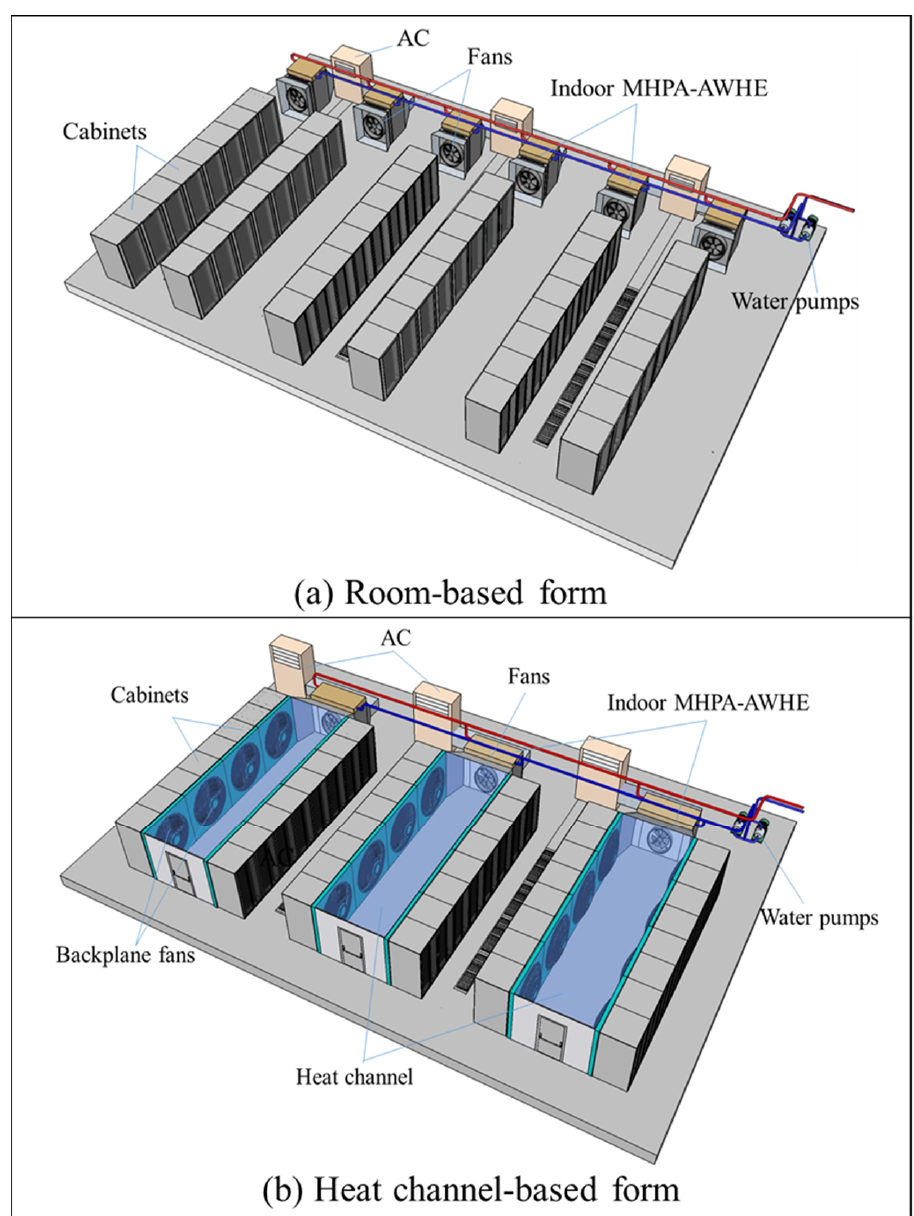
Figure 5. Two forms of heat dissipation conditions of indoor data centers.